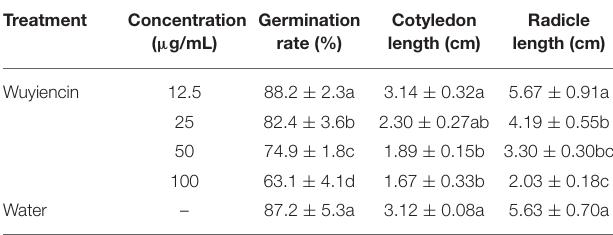
TABLE 2 | Effects of wuyiencin soaking on germination rate and growth of soybean seeds.